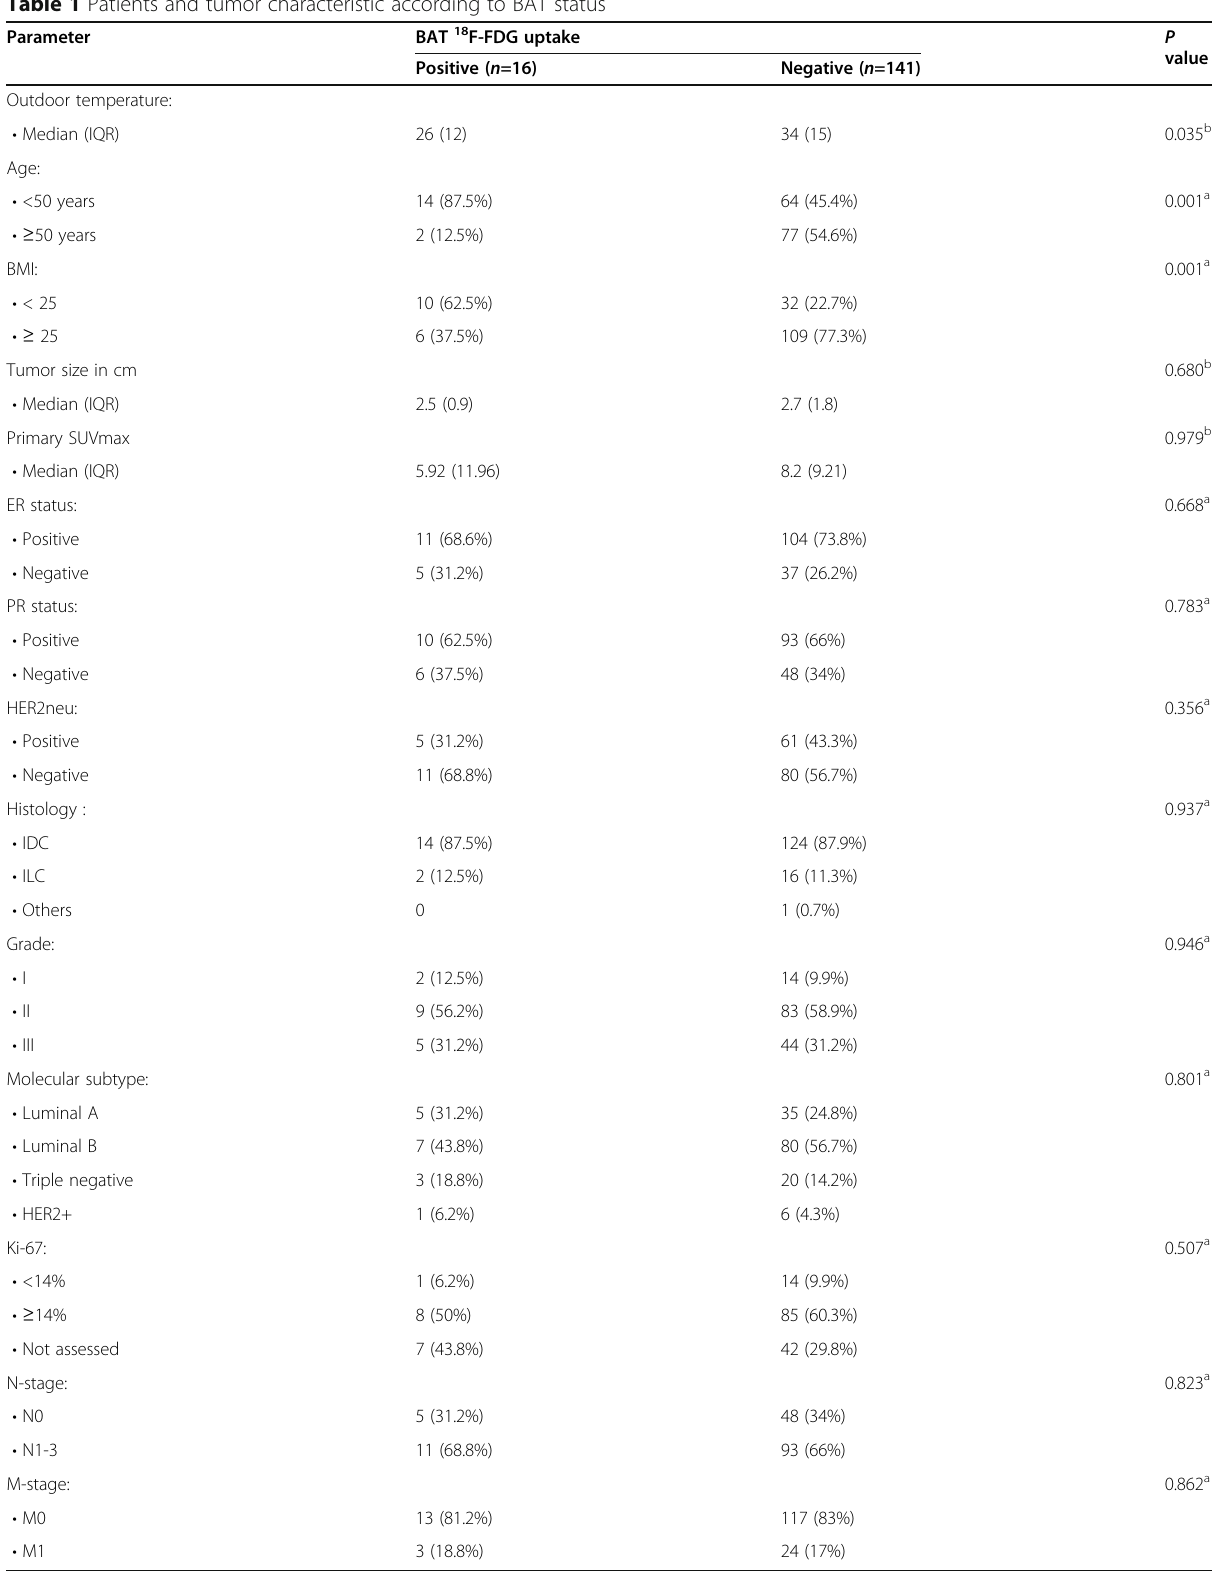
Table 1 Patients and tumor characteristic according to BAT status